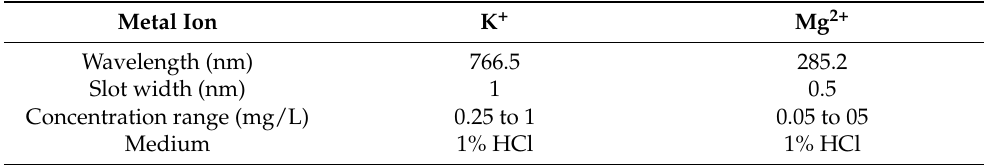
Table 9. Experimental conditions for the determination of potassium and magnesium with atomic absorption